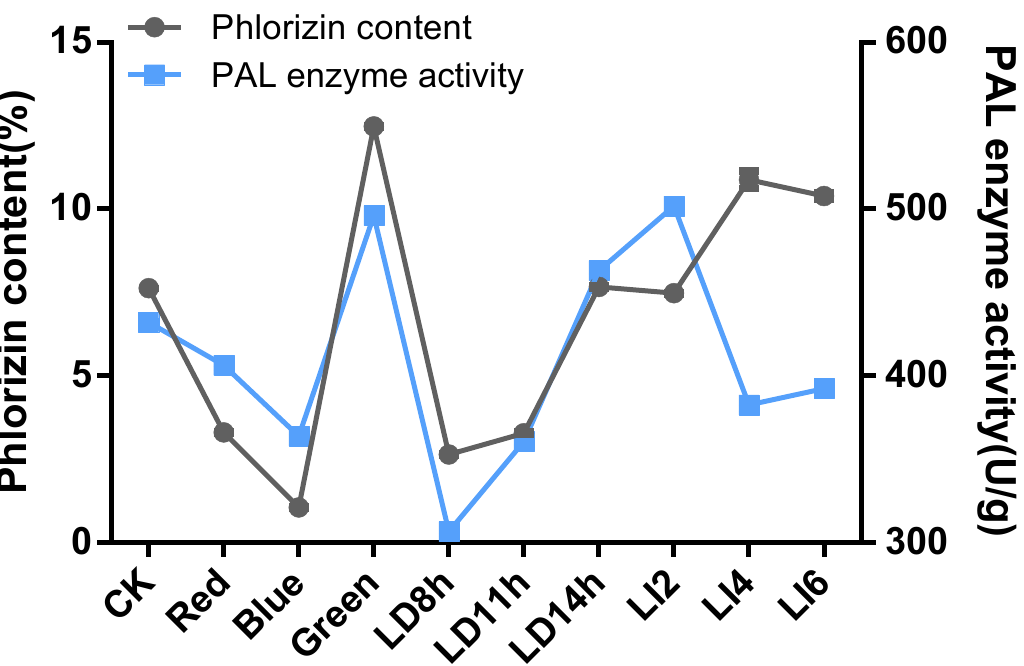
Figure 9. Changes to the phlorizin content and PAL activity due to various light treatments. The gray and blue lines correspond to the phlorizin content and PAL activity, respectively. The phlorizin content refers to the percentage of the extracted phlorizin mass to the dry weight of the